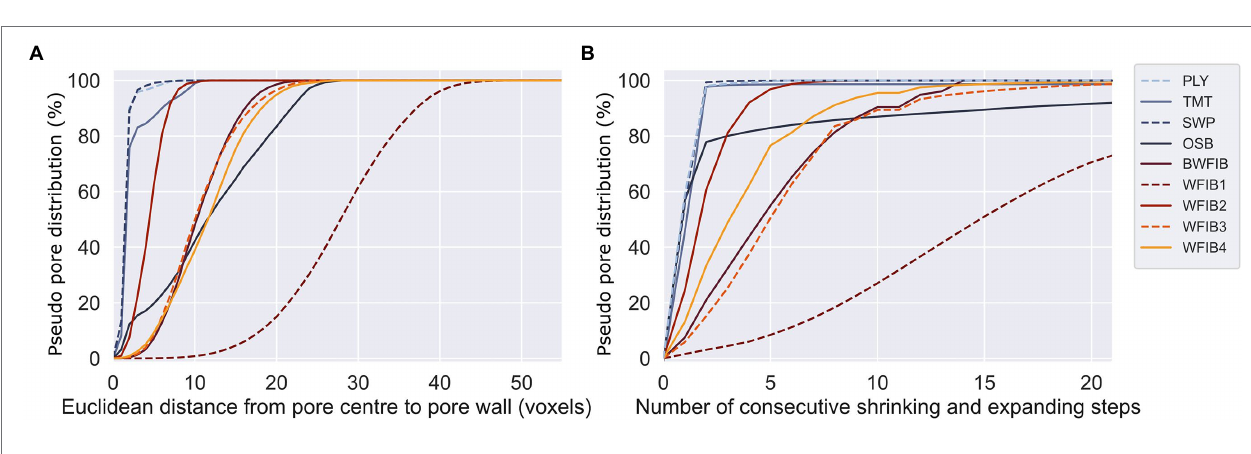
FIGURE 4 | Cumulative representation of pseudo-pore distributions (X-ray micro CT at 6–6.5 μ m resolution) of one reference specimen per material based on (A) Euclidean distance – skeletonization approach and (B) on shrink and expand approach. PLY, Plywood radiata pine; TMT, Thermally modified spruce; SWP, Three-layer spruce panel; OSB, Oriented strand board; BWFIB, Bituminised wood fibre board; WFIB1-4, Wood fibre insulation board type